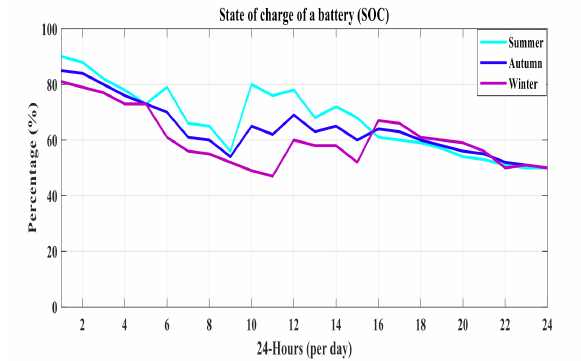
Fig. 4. State of charge of a battery (SOC) attraction in between them, then they will be moving at random in an open search space. (c) The brightness of the fireflies decides the objective of the work. Light concentration I(r) and engaging qual- ity are the two vital criteria within the advancement of firefly calculation. Simply it is accepted as brightness of firefly decides its engaging quality. The difference of light concentration of distance can be found approx- imately by using the below